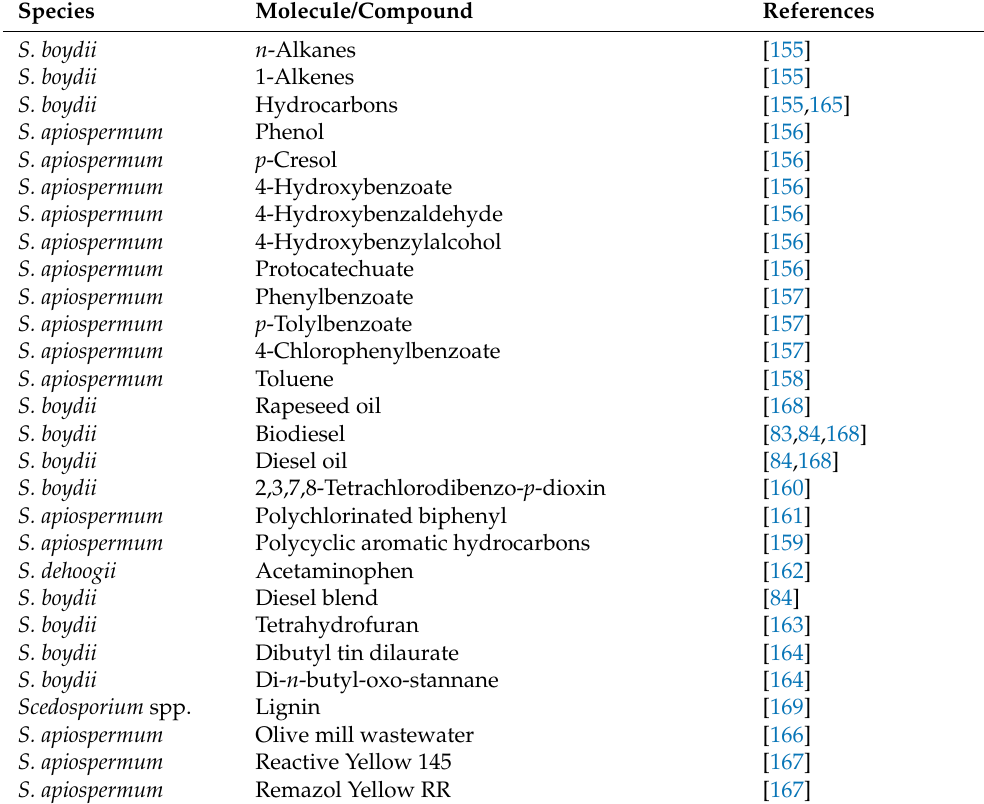
Table 2. List of xenobiotics degraded by Scedosporium species in the literature.